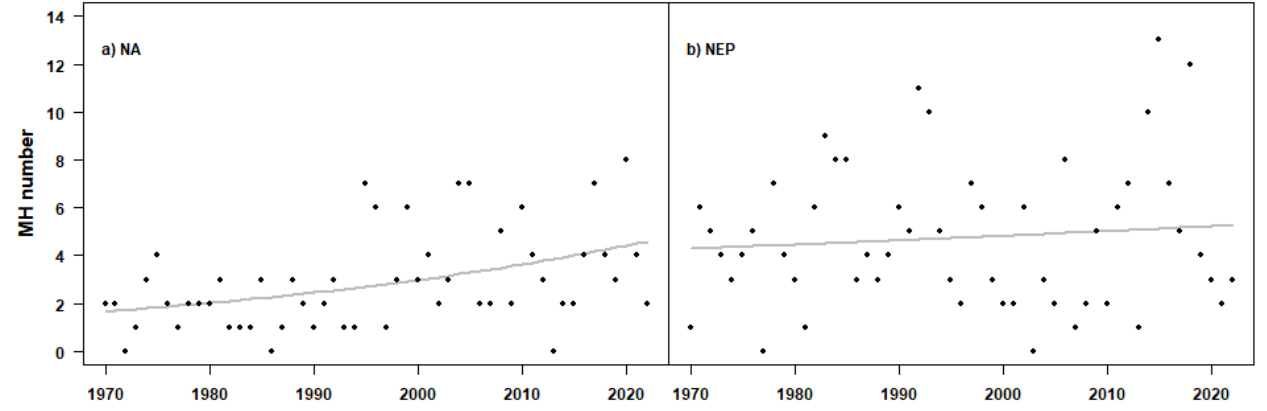
Figure 3. Annual number and trend of MHs in: ( a ) the NA basin ( p < 0.01); and ( b ) the NEP basin ( p > 0.1).